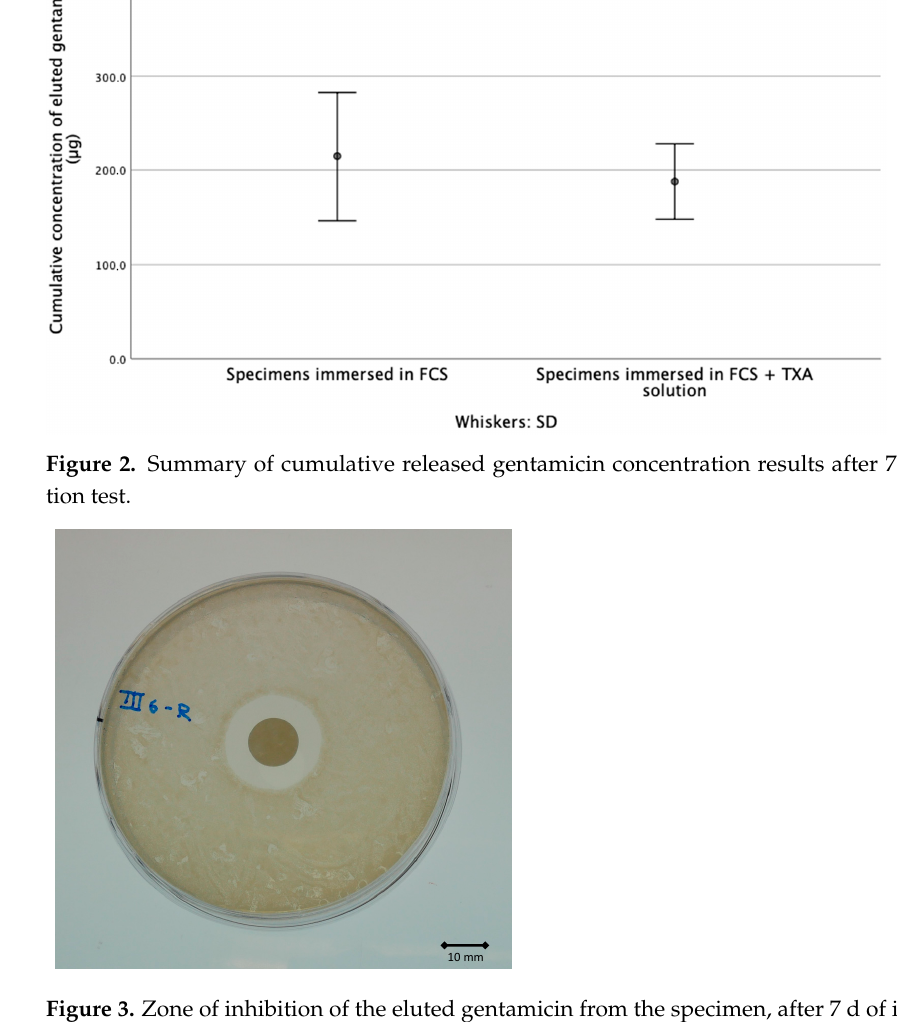
Figure 4. Summary of the zone of inhibition of the cements, after 7 d of immersion in the test solution. 3.3. Compressive Strength After 7 d of immersion in the test fluid, the difference in the compressive strength of the cements in study groups 1 and 2 was not significant ( p = 0.262) (Figure 5).